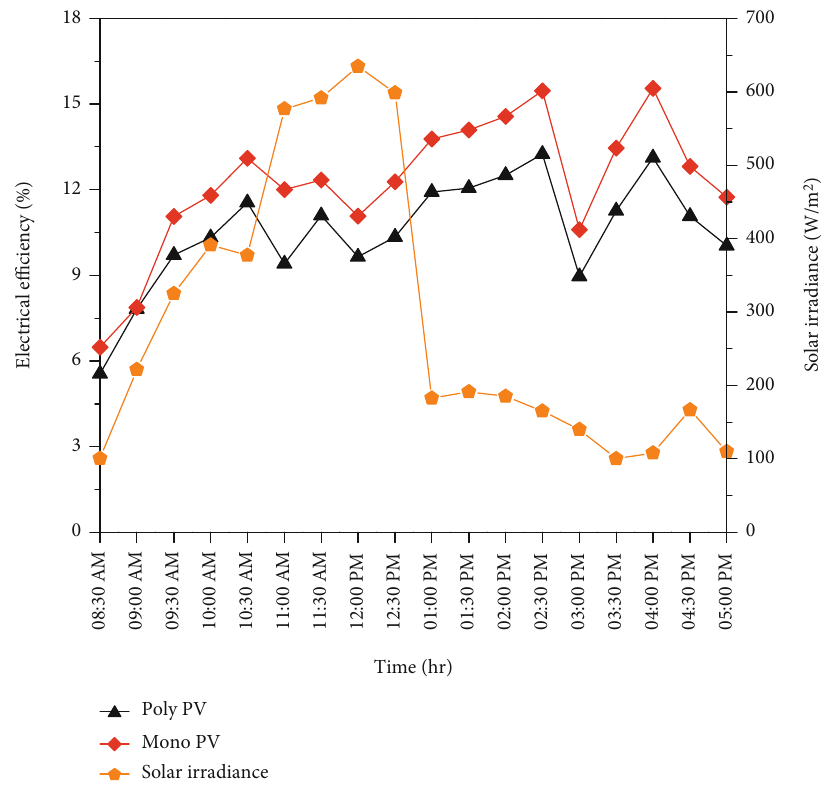
Figure 8: Electrical e ffi ciency with respect to time and solar